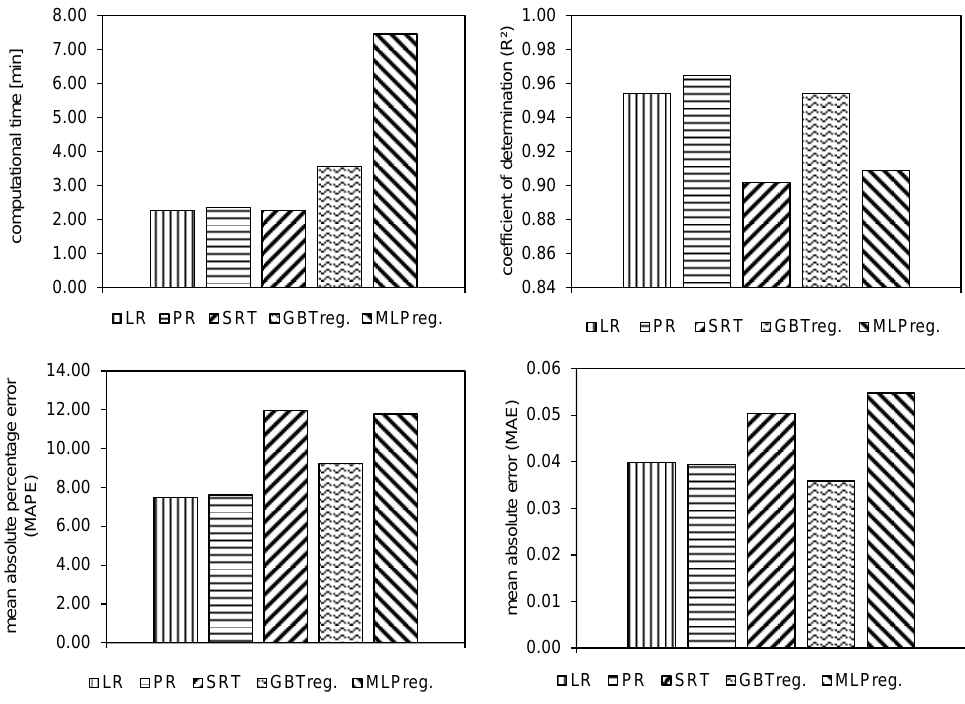
Figure A1. Summary of data mining results predicting the cooling capacity.